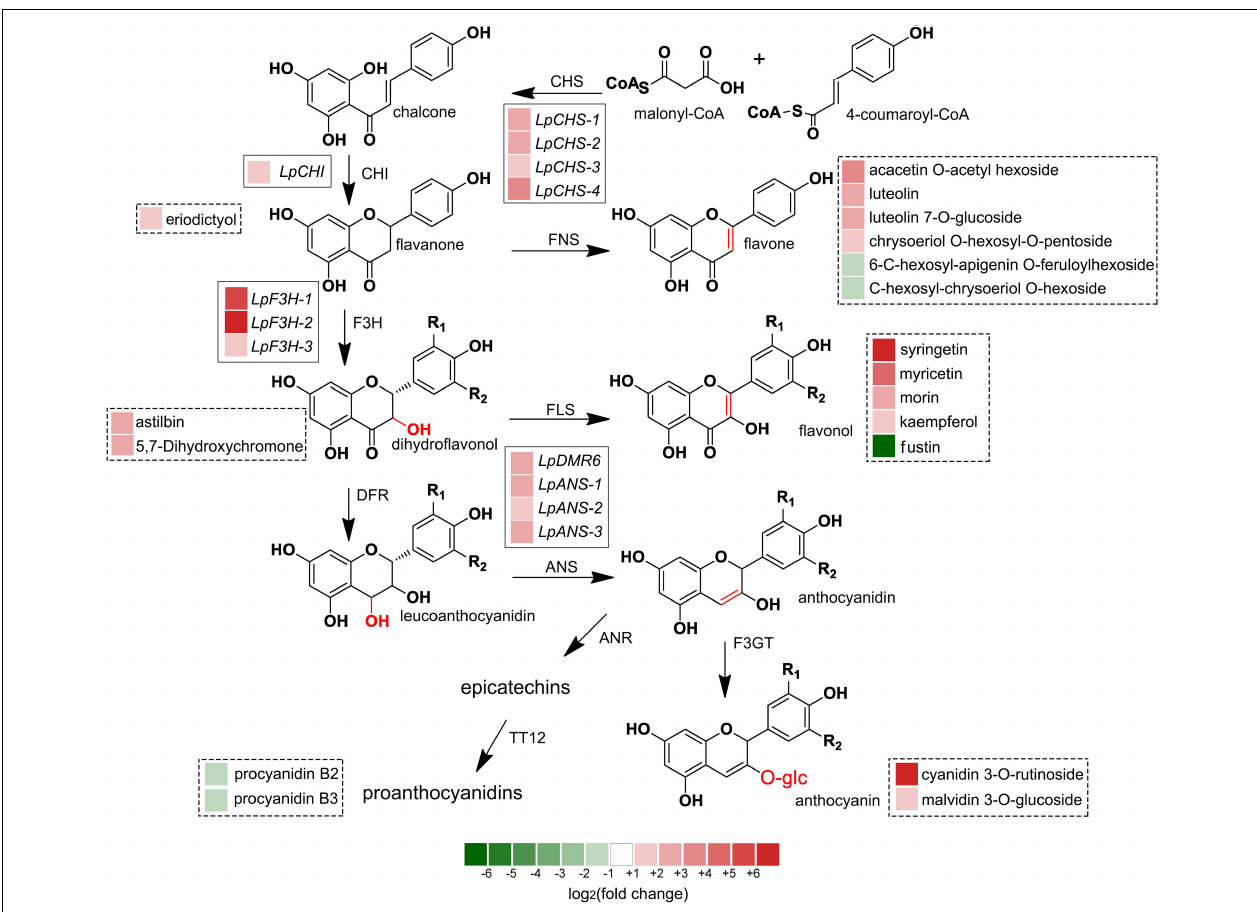
FIGURE 9 | Integrated transcriptome and metabolome analysis showed that flavonoid biosynthesis might contribute the resistance of Antarctic moss against UV-B radiation. The left block of each gene and metabolite indicated the log 2 (fold change) of this gene and metabolite between control and UV-B radiation. Genes labeled in solid line box and metabolites showed in dotted